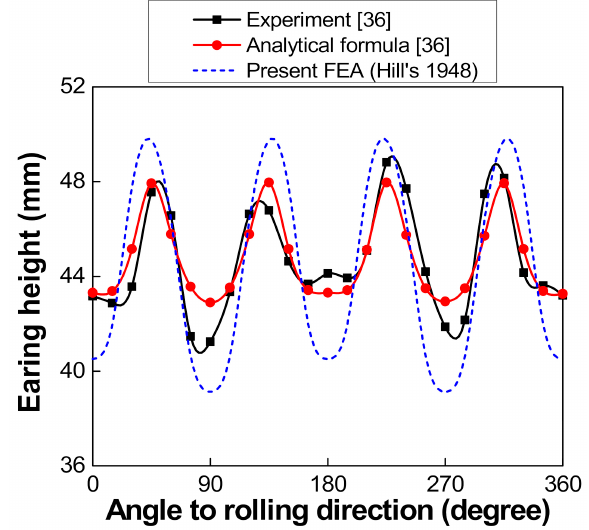
Figure 9. Prediction of earing height profile of AA2093-T3 using the present FEA (Hill’s1948) compared to the analytical formula and experimental data in the previous study [36] for verification.